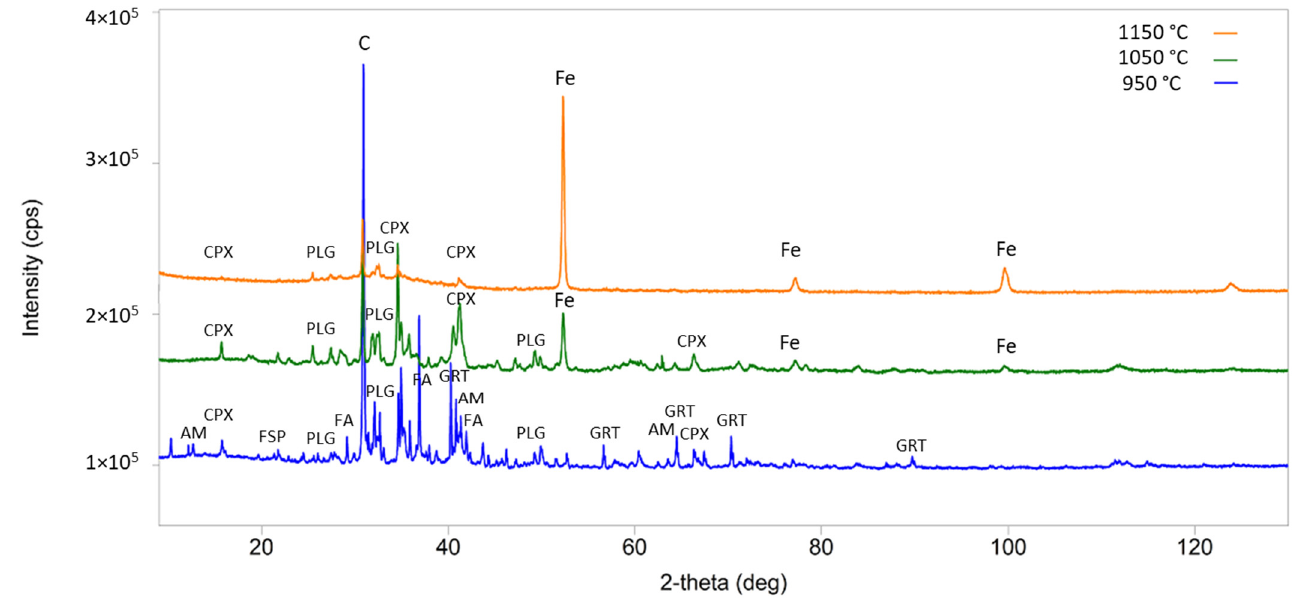
Figure 12. XRD patterns of concentrate R3 reduced at temperatures of 950, 1050, and 1150 °C. Mineral abbreviations: AM = amphibole, CPX = clinopyroxene, FA = fayalite, GRT = garnet, PL = plagioclase, FSP = potassium feldspar, C = graphite, Fe = metallic iron.